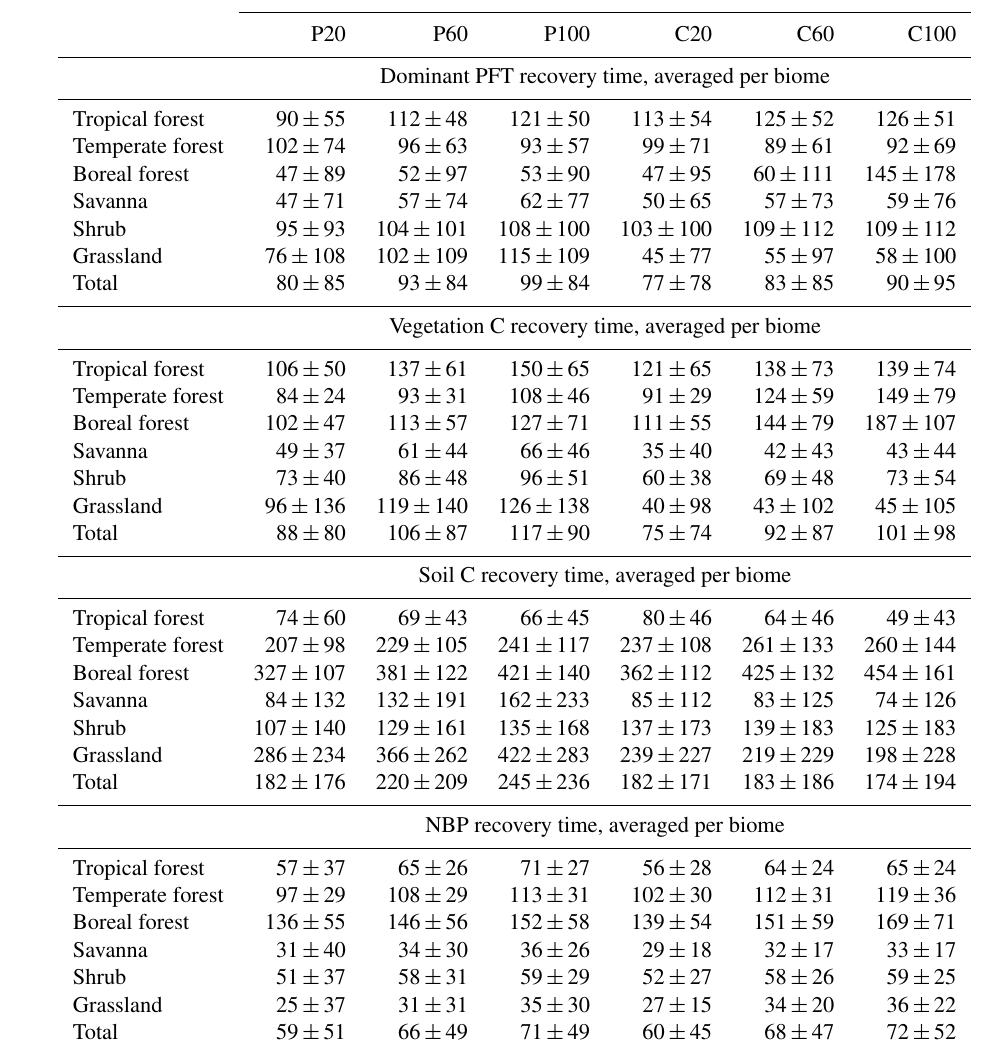
Table 1. Average recovery times and standard deviations per biome and for each simulation. Recovery times are depicted in Fig. 3.